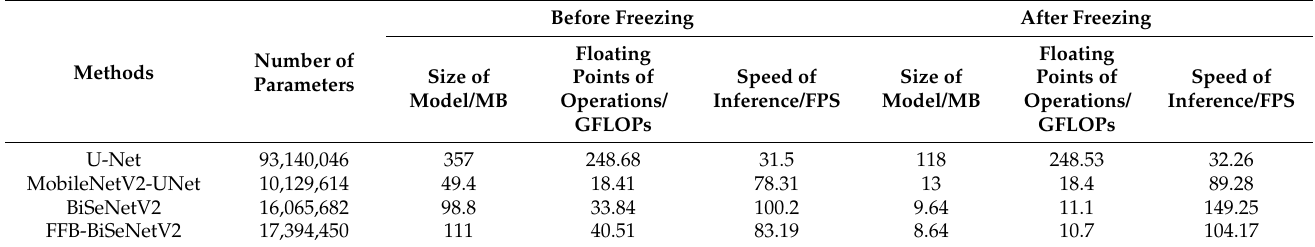
Table 2. Comparison of model parameters and operation